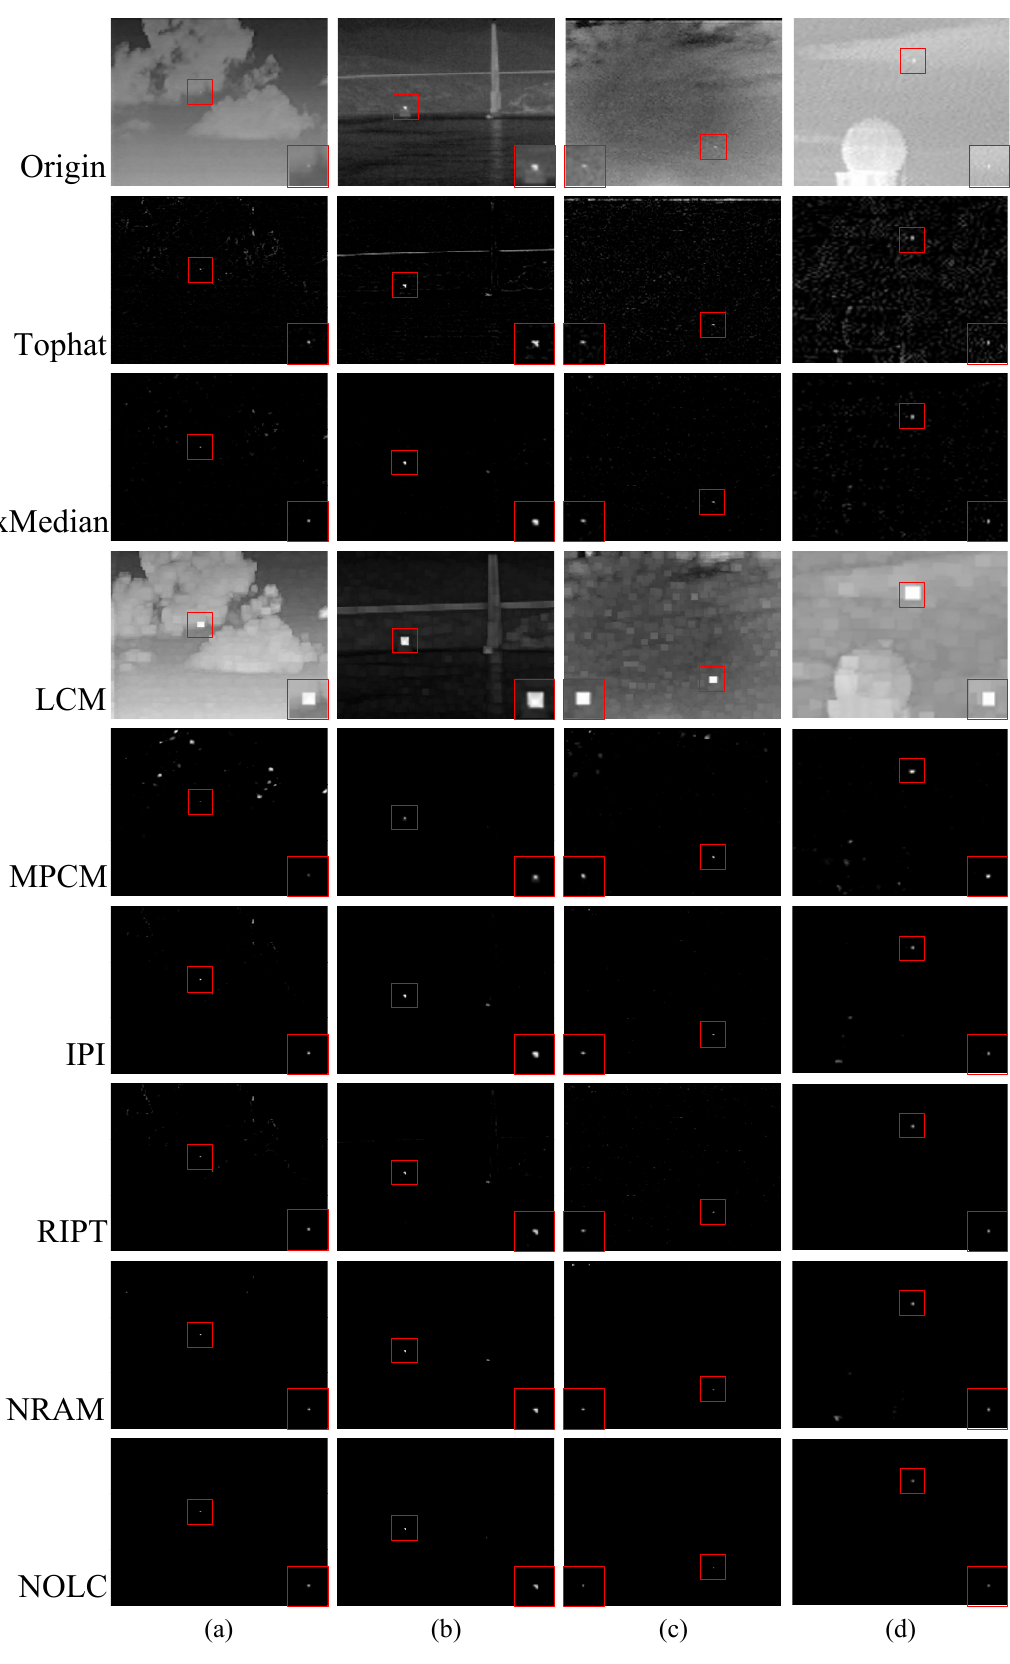
Figure 14. Comparison of four complex scenes. (a)–(d) are scenes 1–4.